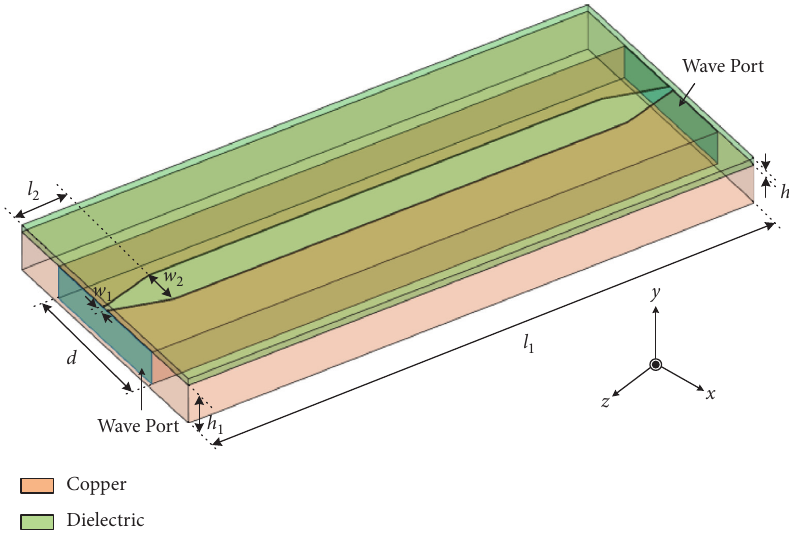
Figure 2: Schematics of the proposed SRW structure.